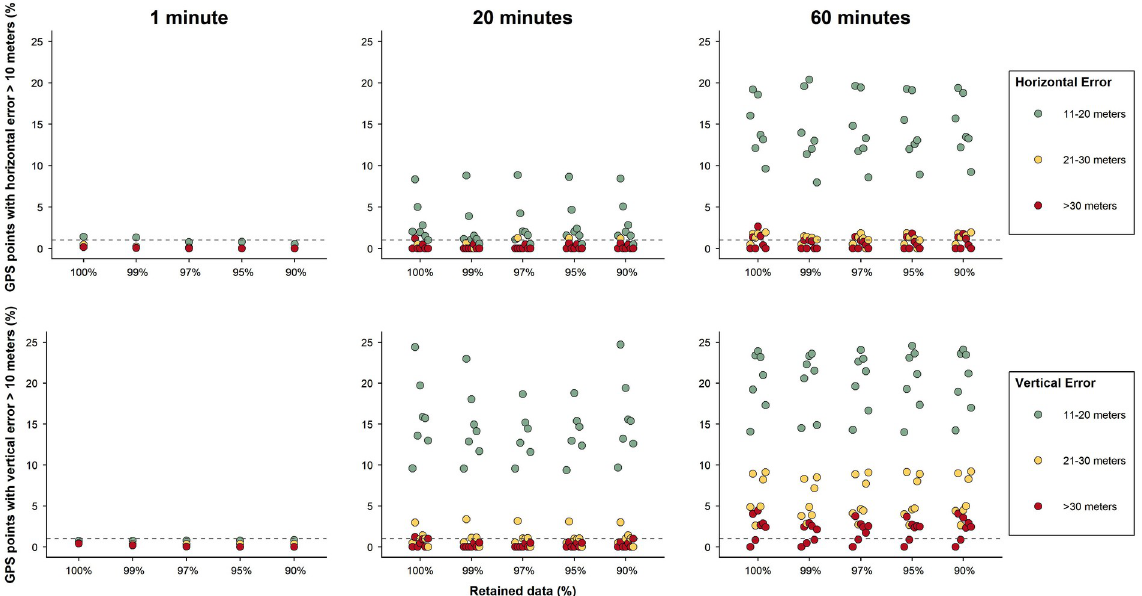
Fig 3. Identification of inaccurate positions in different GPS fix intervals. Percentage of locations with horizontal and vertical error larger than 10 meters for each device, and after removing the points with largest GPS-Error and remaining with 99%, 97%, 93%, 95% and 90% of the original data. The dash line indicates 1% of locations with vertical and horizontal errors larger than 10